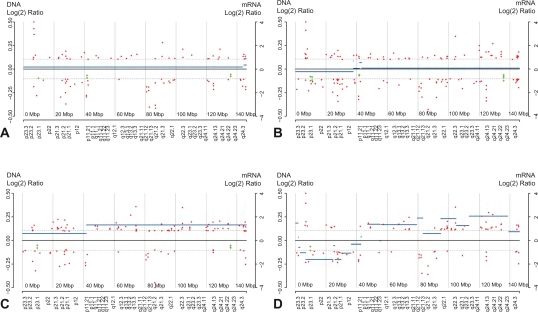
DNA copy number changes on chromosome 8 in Dukes A, B, C and D tumors. Significantly altered DNA segments are indicated by solid lines. Genes with significantly altered expression are indicated by red (mRNA) and green (microRNAs). Dashed lines indicate thresholds for statistically significant DNA segment alterations.